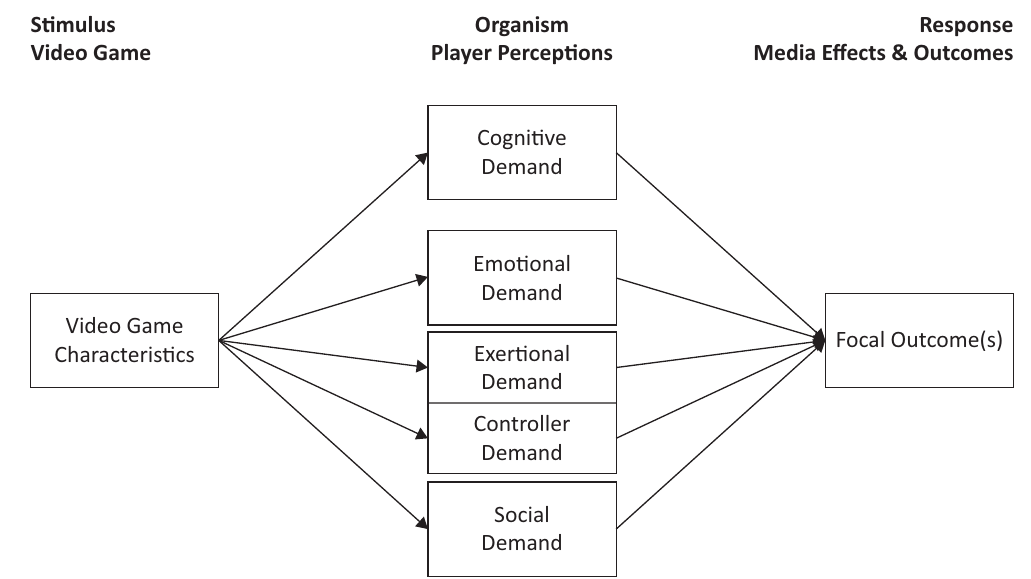
Figure 1. A conceptual model of